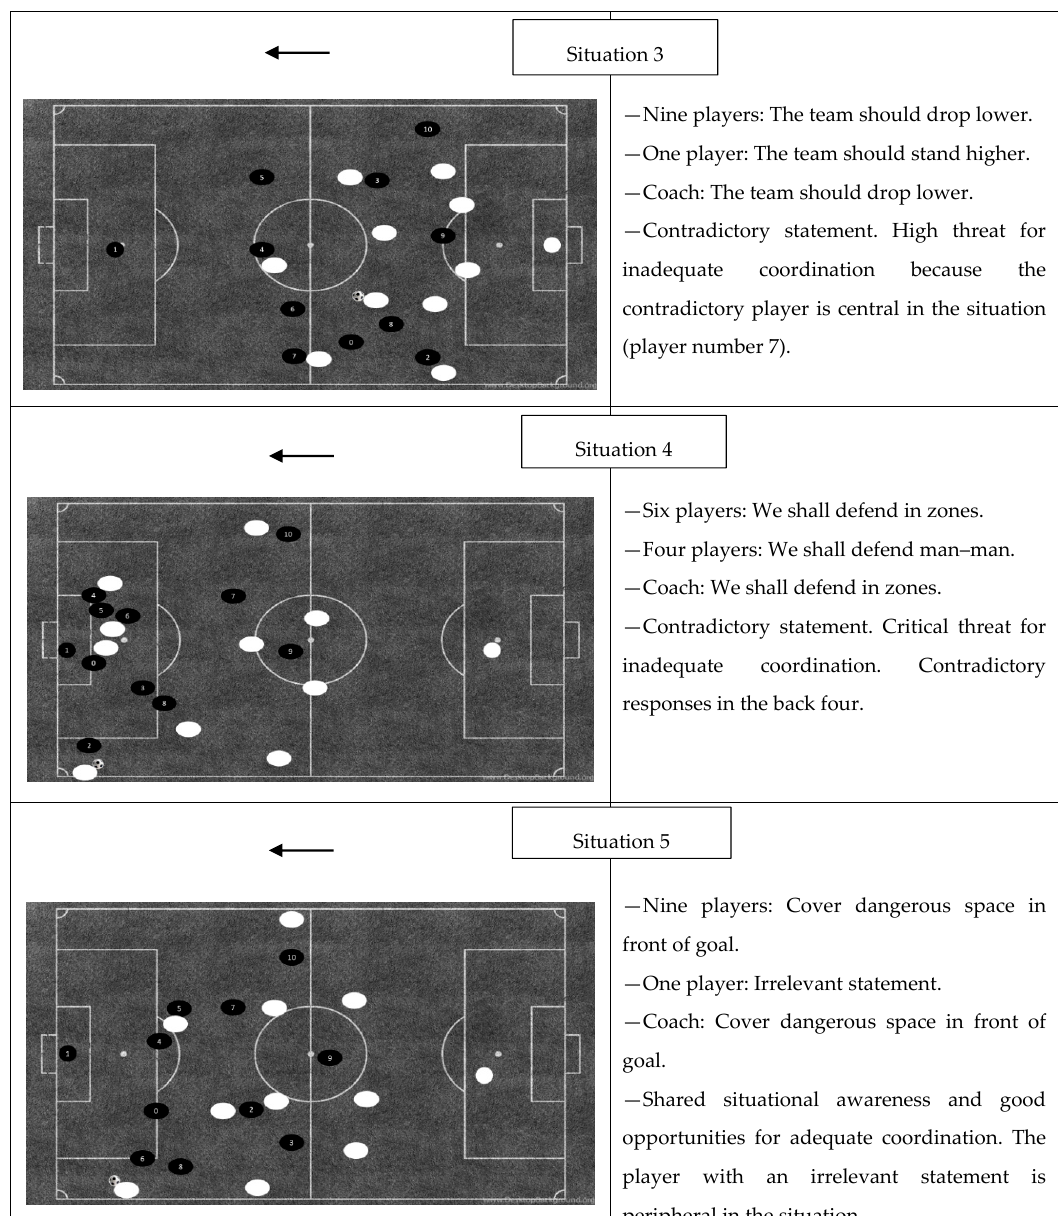
goal. —Shared situational awareness and good opportunities for adequate coordination. The player with an irrelevant statement is peripheral in the situation.